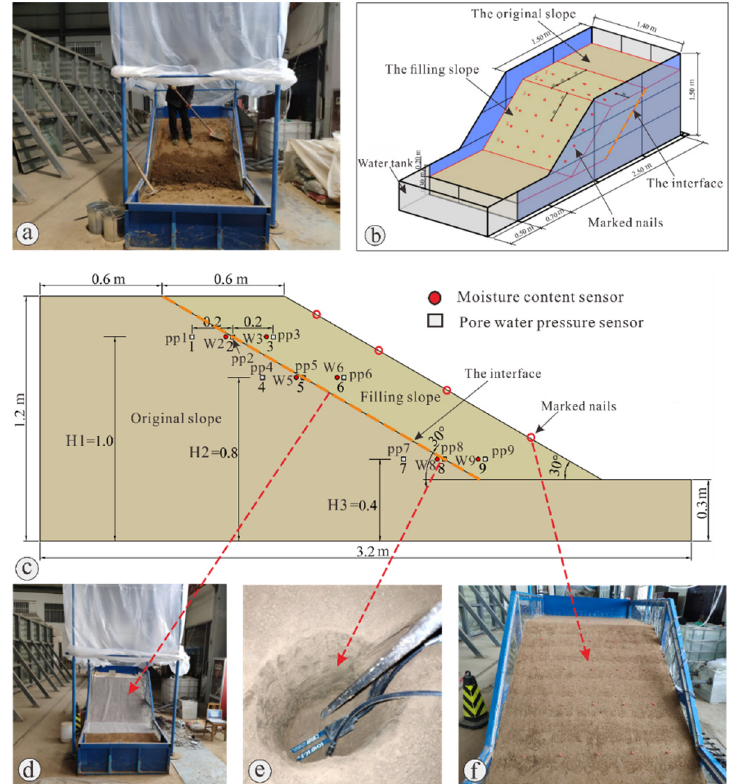
Figure 2. Schematic diagrams of the experiment design. ( a ) Original slope cutting, ( b ) model stereogram, ( c ) model side view, ( d ) slip zone model-Plastic mesh, ( e ) sensor embedding and ( f ) layout of slope tracing points-Plastic mesh.